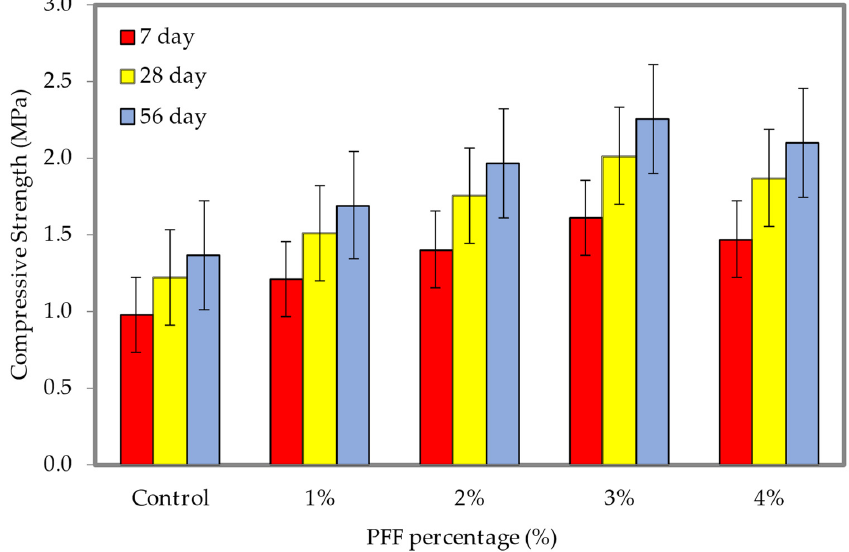
Figure 14. Compressive strength of foamed concrete of 600 kg/m 3 density with varying PFF percentages.